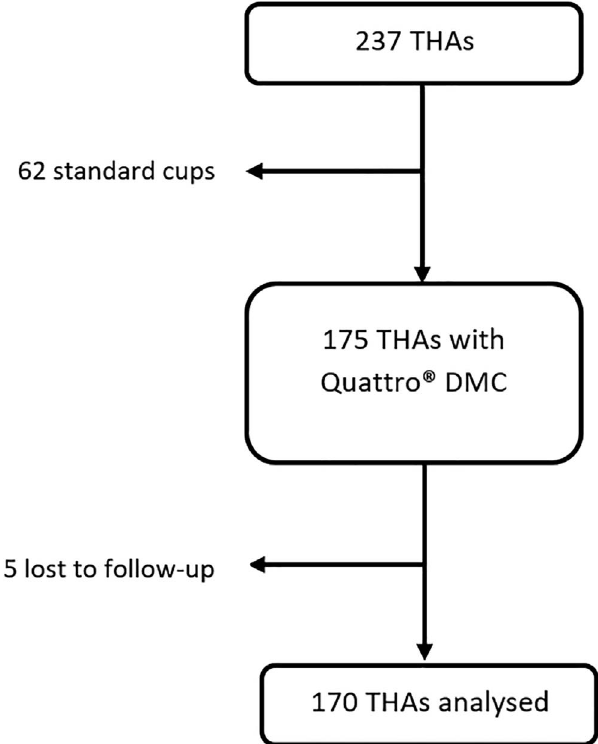
Figure 2. Flowchart, THA: total hip arthroplasty, DMC: dual mobility